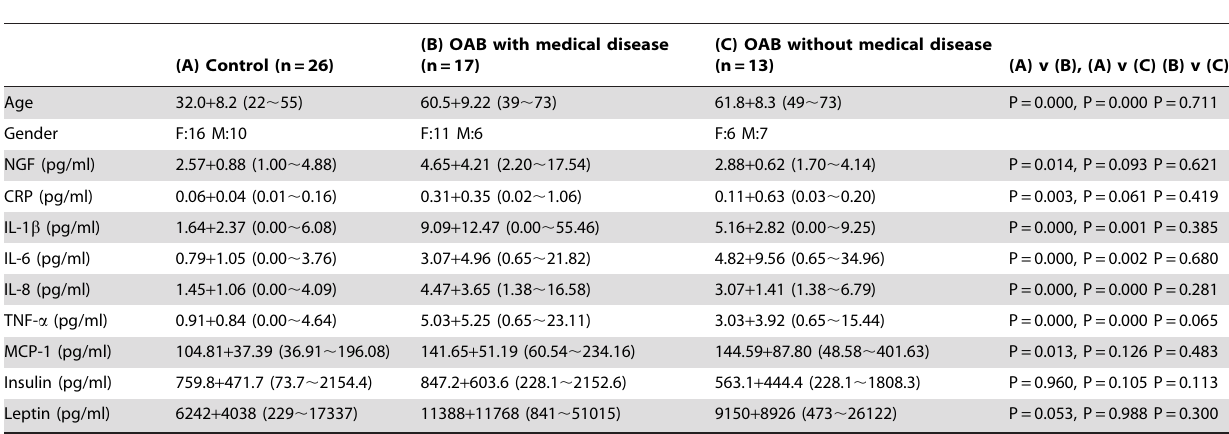
Table 2. The serum NGF, CRP, and adipokines expressions among the controls and OAB patients with and without medical disease.